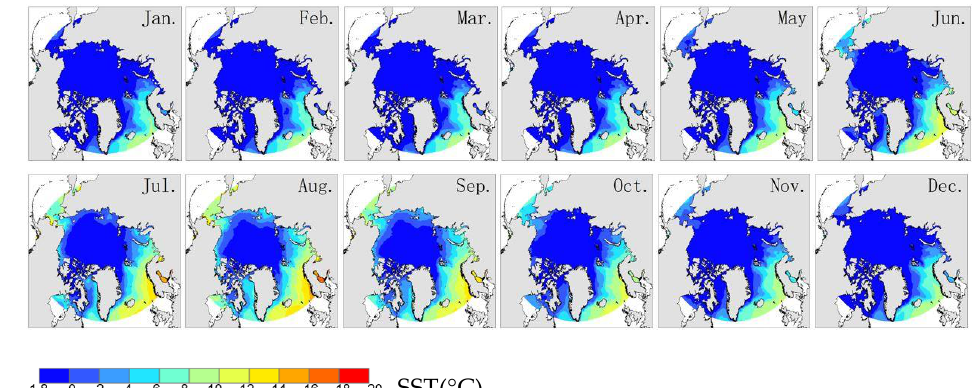
Figure 3. Monthly mean SST of Arctic from 2002 to 2021.